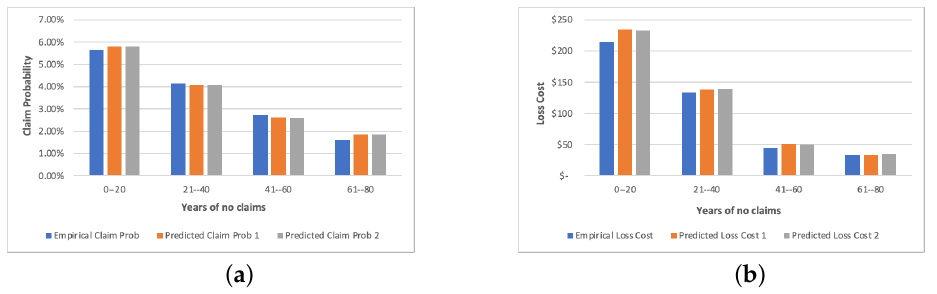
Figure 6. Comparison of empirical and predicted values of claim probability and loss cost by Years of no Claims ( a ) presents the results of claim probability. ( b ) corresponds to the loss cost. The orange bar shows results for predictions without using clusters. The grey bar presents results for predictions with designed